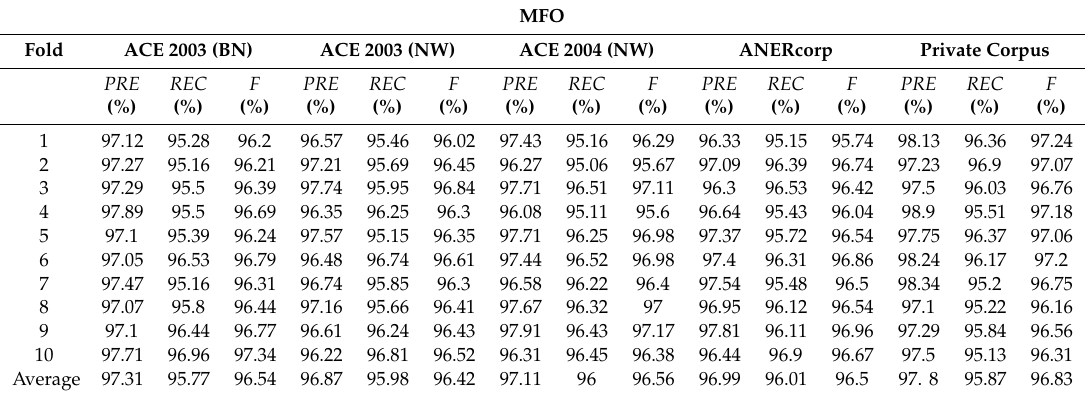
Table A5. Performance evaluation of ontology learning using the MFO over the five corpora.